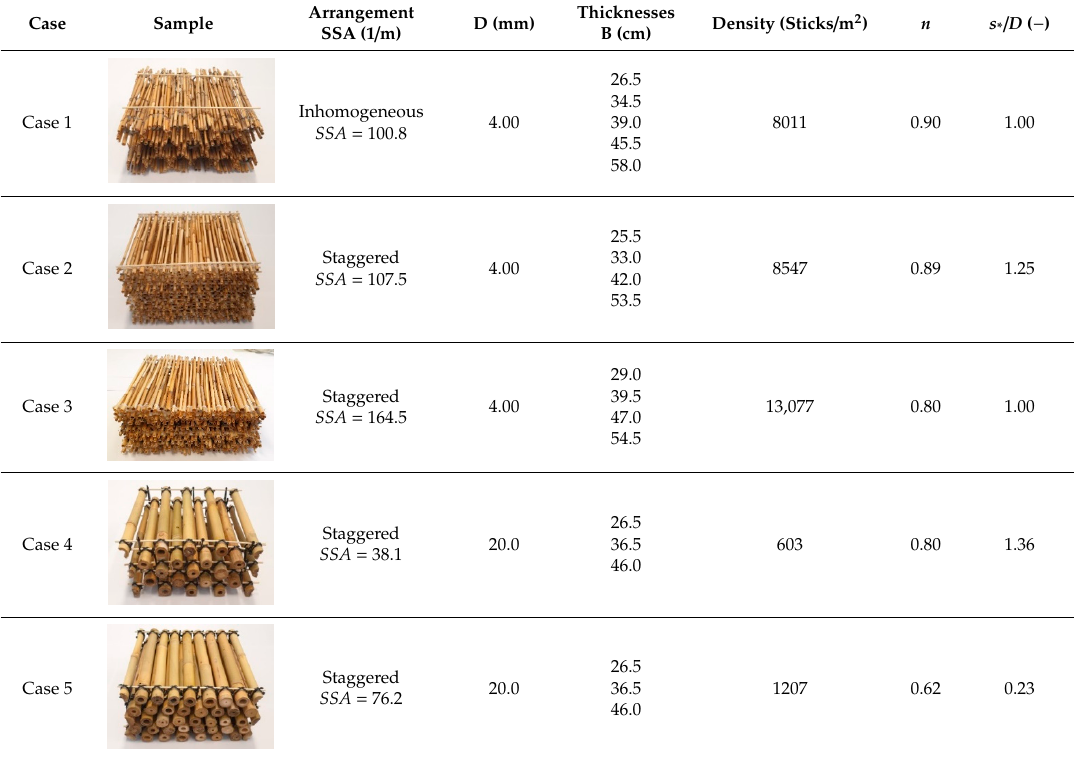
Figure 5. The configurations of wooden fence used in this study: inhomogeneous arrangement ( a ), and staggered arrangement ( b ). The “*” denotes the model and the real scale, D m and D p , respectively. Table 2. Samples of bamboo fences in